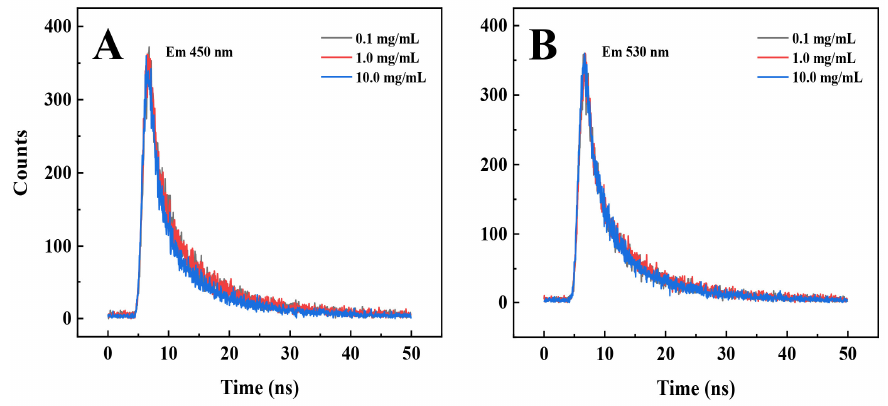
Figure 10. Time-resolved PL decay curves of PEI@CNDs at 0.1, 1.0 and 10.0 mg/mL. ( A ) λ em = 450 nm, and λ ex = 375 nm; and ( B ) λ em = 530 nm, and λ ex = 420 nm. Table 1. Fluorescence lifetimes of PEI@CNDs solutions at different concentrations (0.1, 1.0, and 10.0 mg/mL) with 375 nm excitation, 450 nm monitoring, and 420 nm excitation, 530 monitoring, respec- tively.